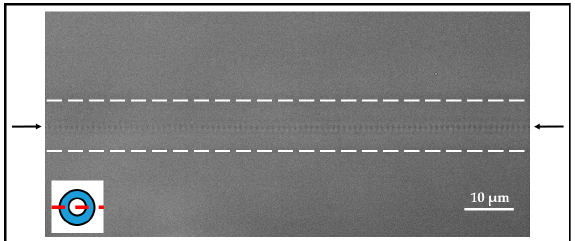
Figure 4. Microscopic image of part of a point ‐ by ‐ point written FBG. The black arrows indicate the position of the individual grating pitches. The dashed lines illustrate the core ‐ cladding ‐ interface. The inset indicates the optical section plane.